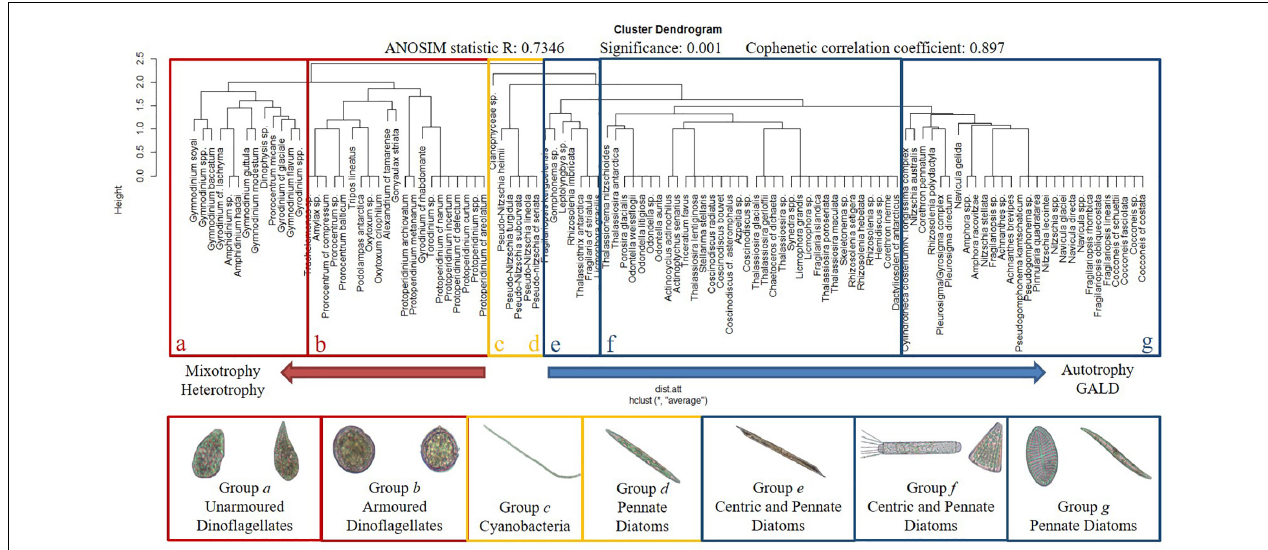
FIGURE 4 | Dendrogram showing the functional groups formed by the presence or absence of the traits and species representing the respective groups. Letters and colors highlighted species groups.